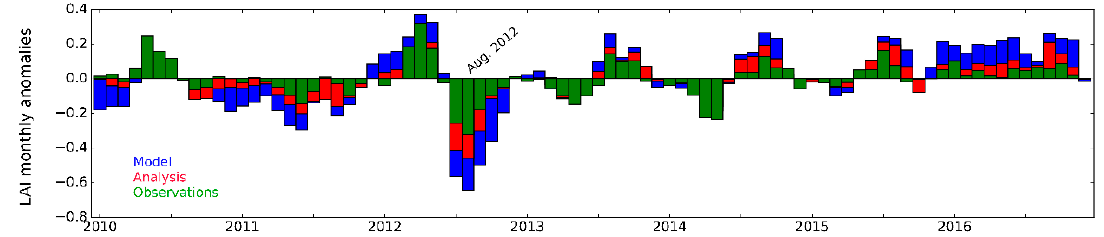
Figure 9. Leaf area index (LAI) monthly anomalies over the 2010–2016 time period for the model (blue bars), the analysis (red bars), and the CGLS GEOV1 observations (in green) over the corn belt drought defined as a box from 110°W to 70°W and 30°N to 50°N.